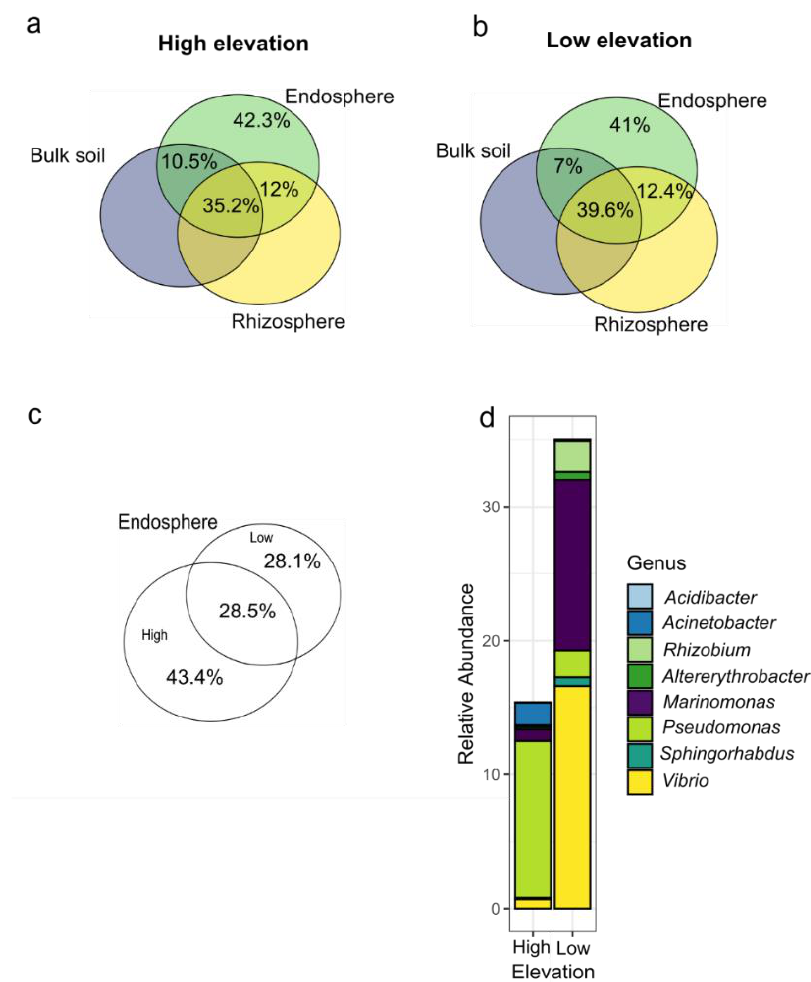
Figure 5. Di ff erences in endosphere bacterial composition in each E. atherica ecotype. Venn diagram showing the proportion of the endosphere ASVs shared with rhizosphere and soil and exclusively found in inner root in HE ecotype (panel a ) and LE ecotype (panel b ). Venn diagram showing the proportion of shared endosphere ASVs among elevations (panel c ). Mean relative abundance of the core bacterial genera at each elevation (panel d ).